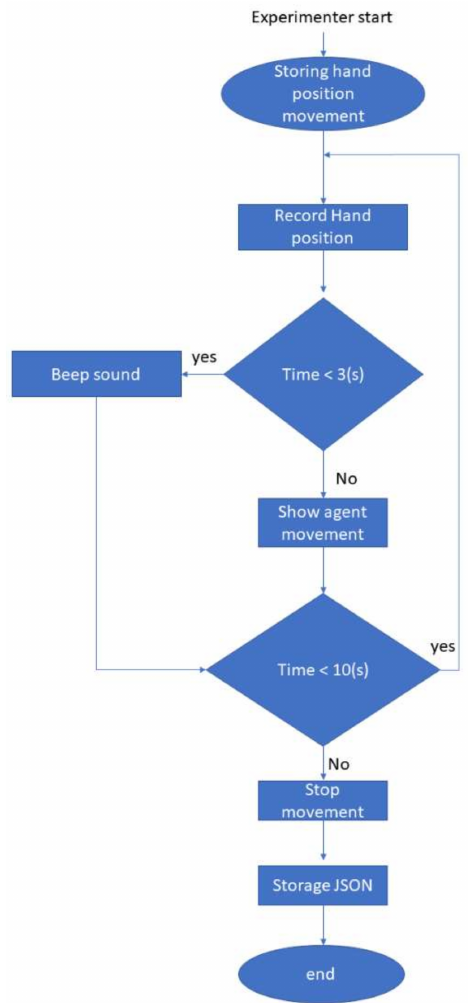
Figure 2. Algorithm system flow of the system for showing agent